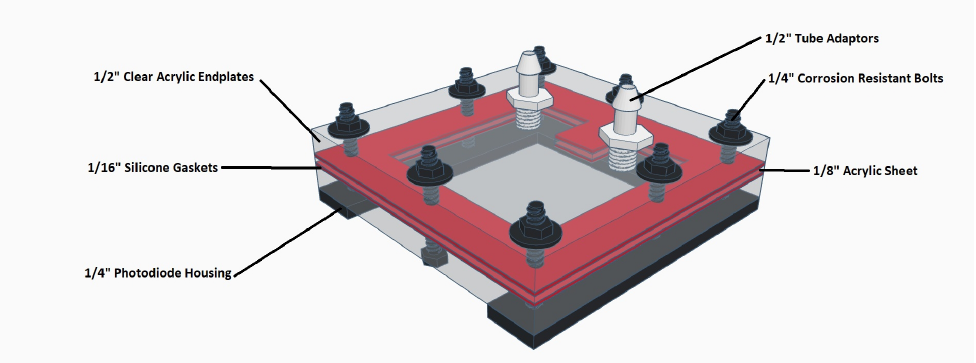
Figure 2. Construction of a clear flow cell (1/4 (cid:48)(cid:48) internal thickness) with housing for ambient light